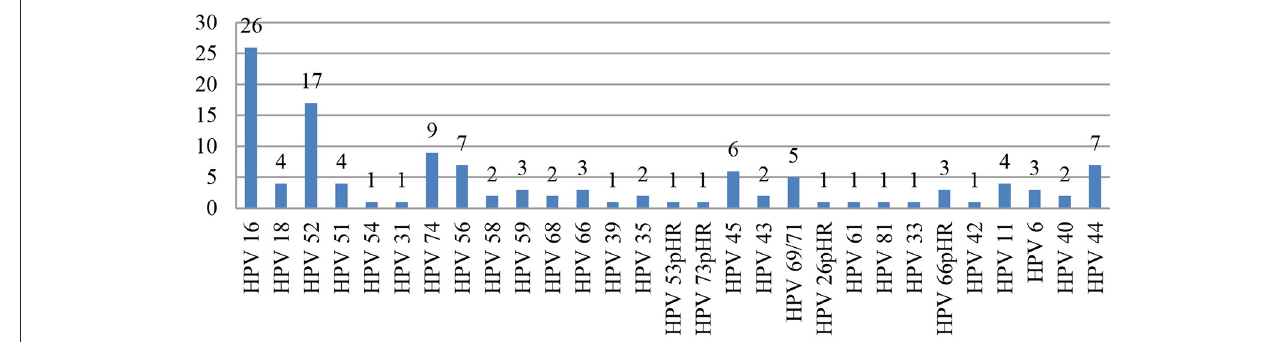
FIGURE 1 | Frequencies of different HPV Genotypes in study samples.